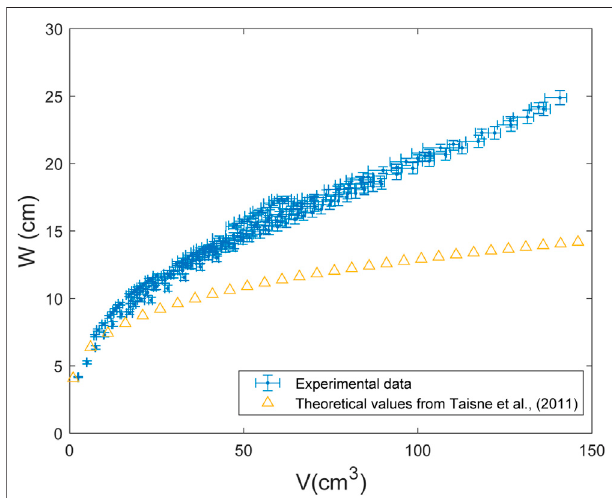
FIGURE8| Variation ofthedike width(W) withtheintrudedvolume(V) in our models ( fl ux-driven dike; blue crosses) and as predicted by Taisne et al., (2011) for buoyancy driven dikes (orange